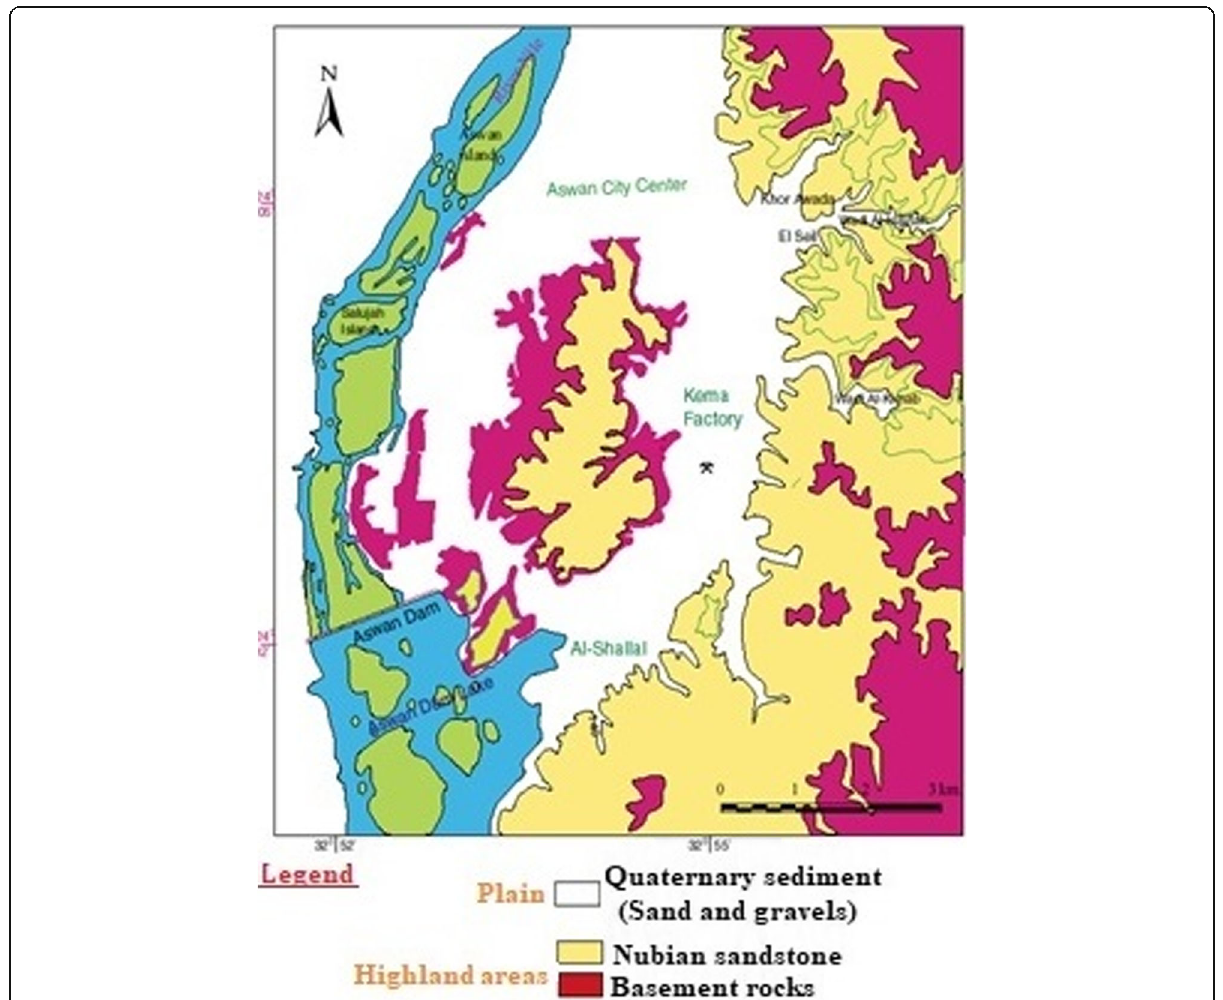
Fig. 2 Geological map of the study area (modified after Egyptian Geological Survey,